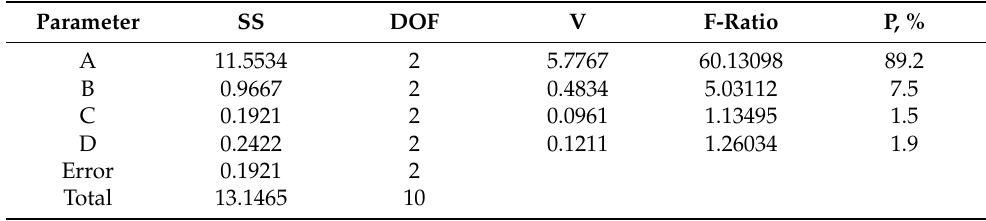
Table 11. Analysis of variance for hardness of the coatings.